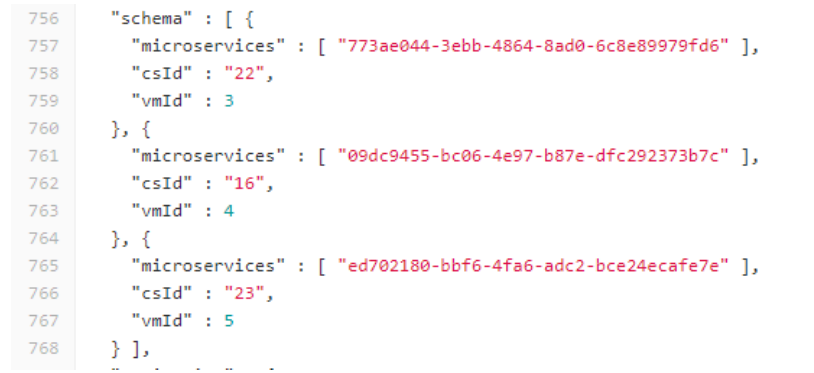
Figure 8. Snippet of the application description JSON file, where the application’s NFRs are described.